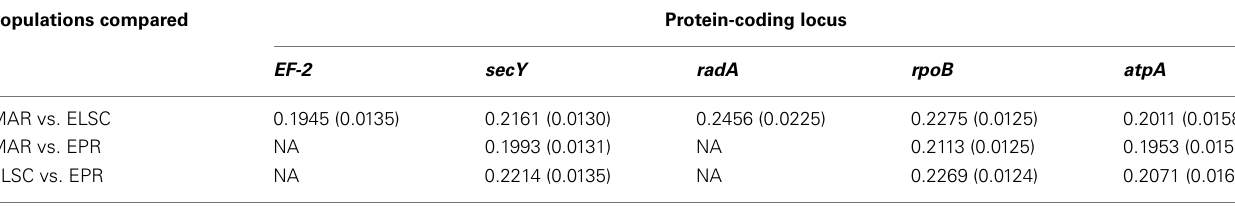
Table 5 | Nucleotide divergence between DHVE2 isolates from different regions. Populations compared Protein-coding